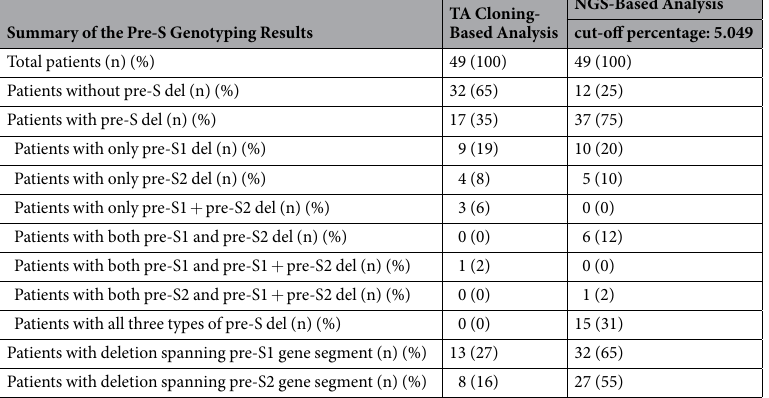
Table 2. Summary of the pre-S genotyping results by TA cloning- and NGS-based analyses in 49 HBV-related HCC patients. Abbreviations: del, deletion; n,